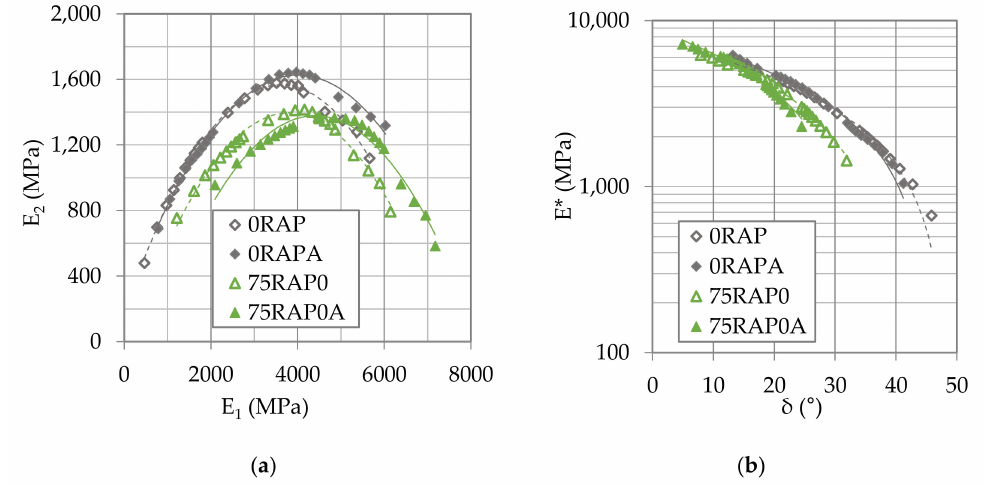
Figure 7. ( a ) Cole-Cole diagram; ( b ) Black diagram. E* is the stiffness